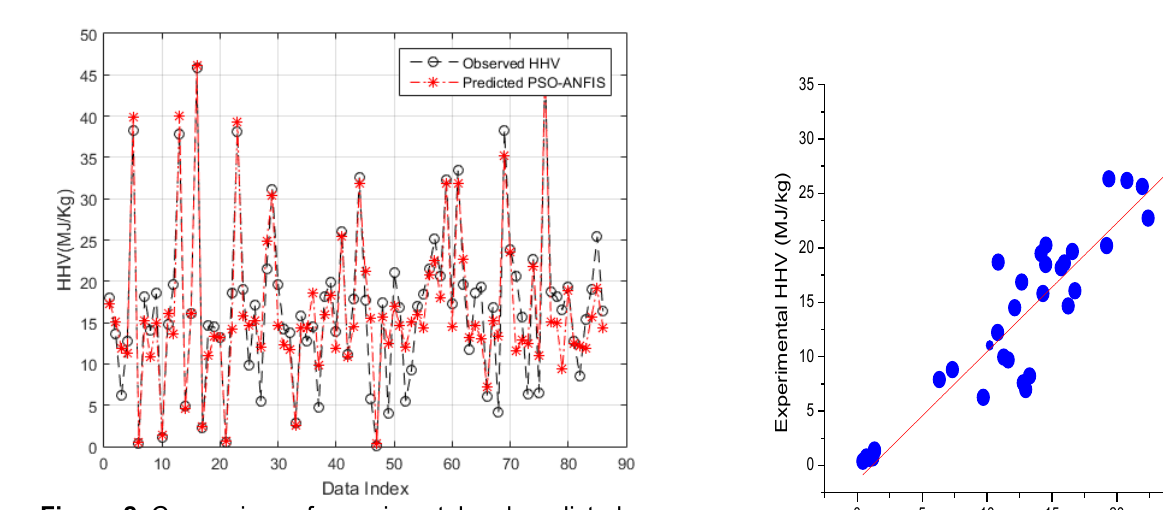
Figure 2. Comparison of experimental and predicted HHV for PSO-ANFIS at training stage